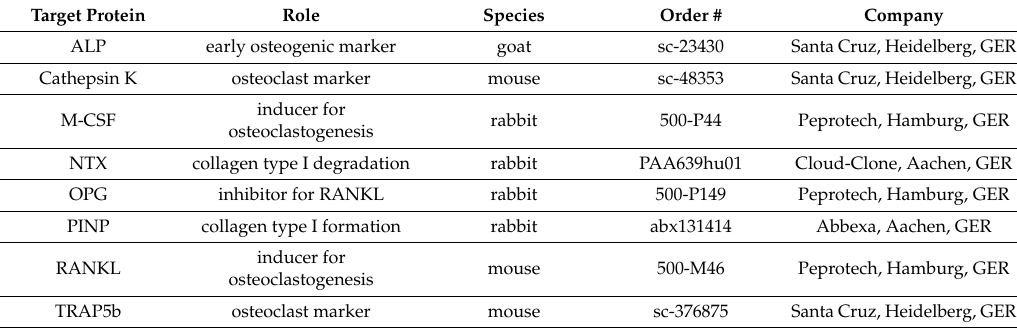
Table 2. Dot blot targets and